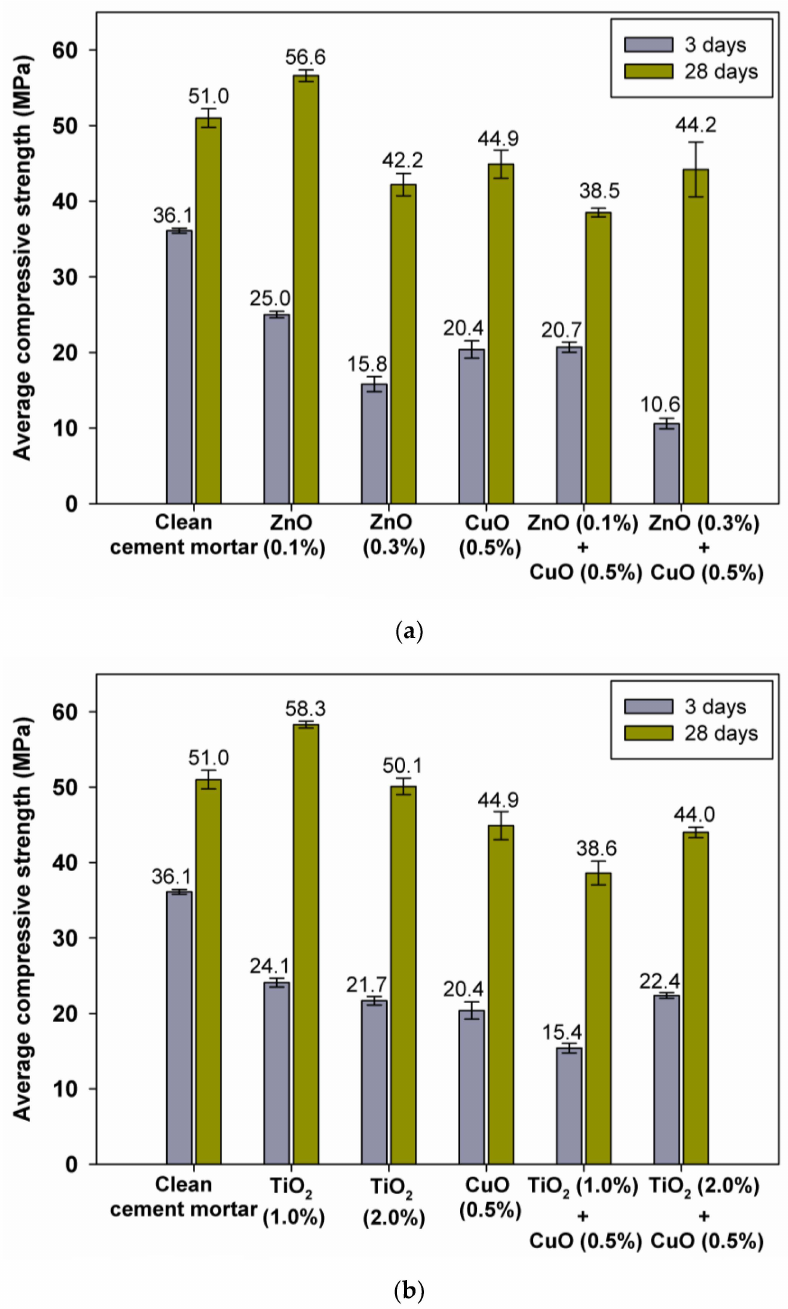
Figure 5. Average compressive strength of samples after 3 and 28 days ( a , b